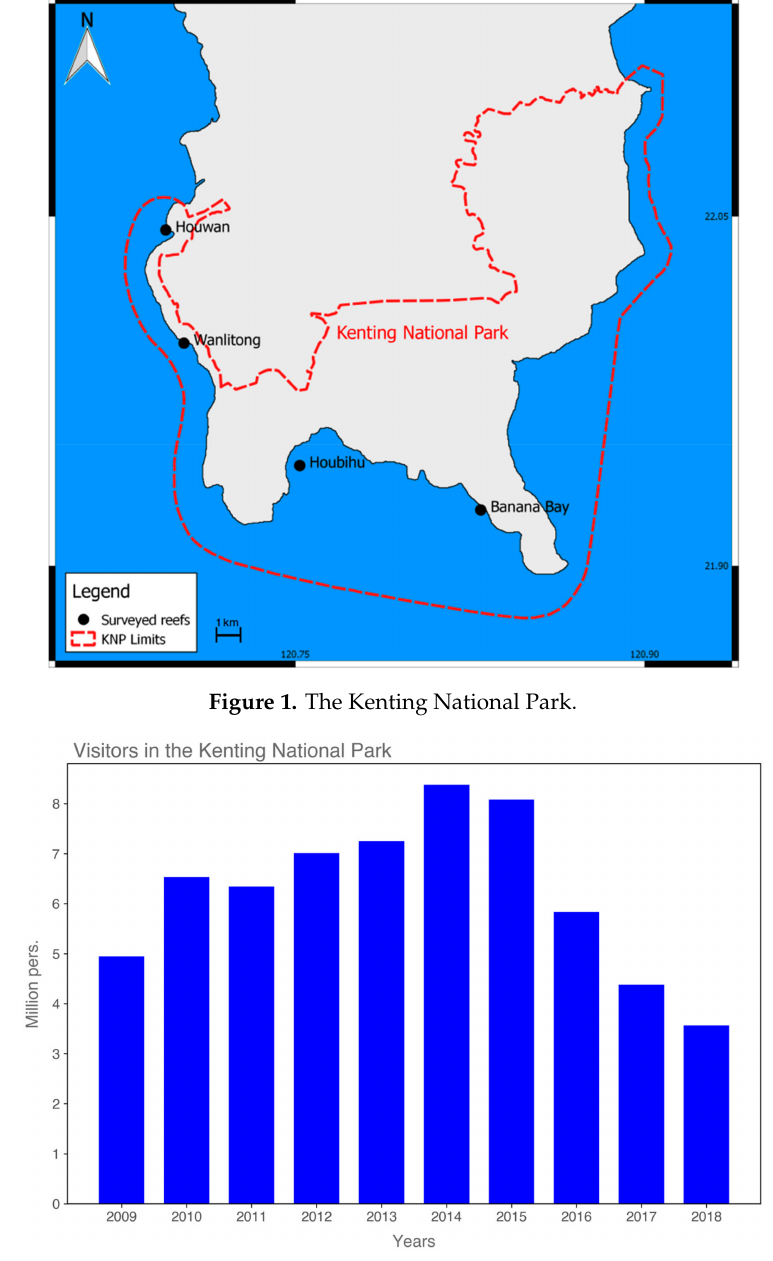
Figure 2. VisitorsintheKentingNationalPark. (https: // www.ktnp.gov.tw / News.aspx?n = 228F1362E45E0B89& sms = 830F4DD99E91DBB7 (accessed on June 10